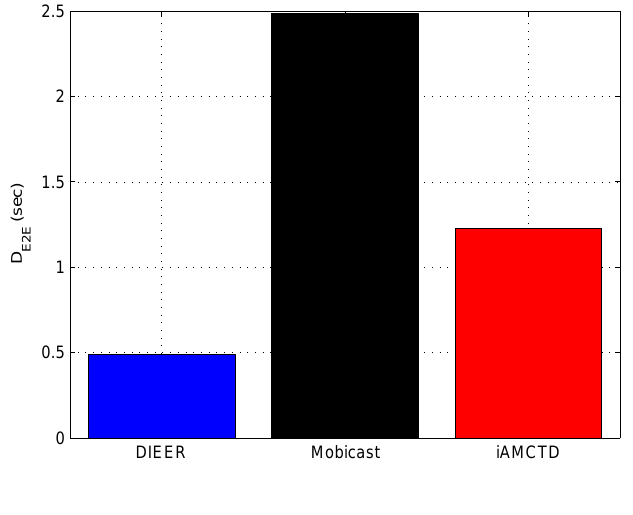
Figure 8. Average D E 2 E